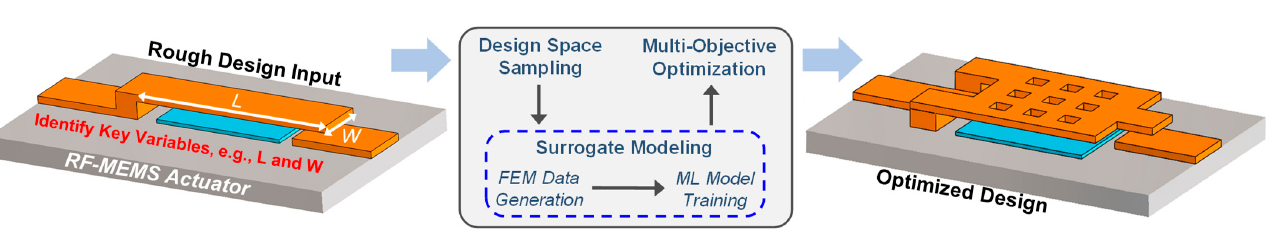
Figure 1. Schematic diagram demonstrating the generic design optimization methodology for RF- MEMS devices.